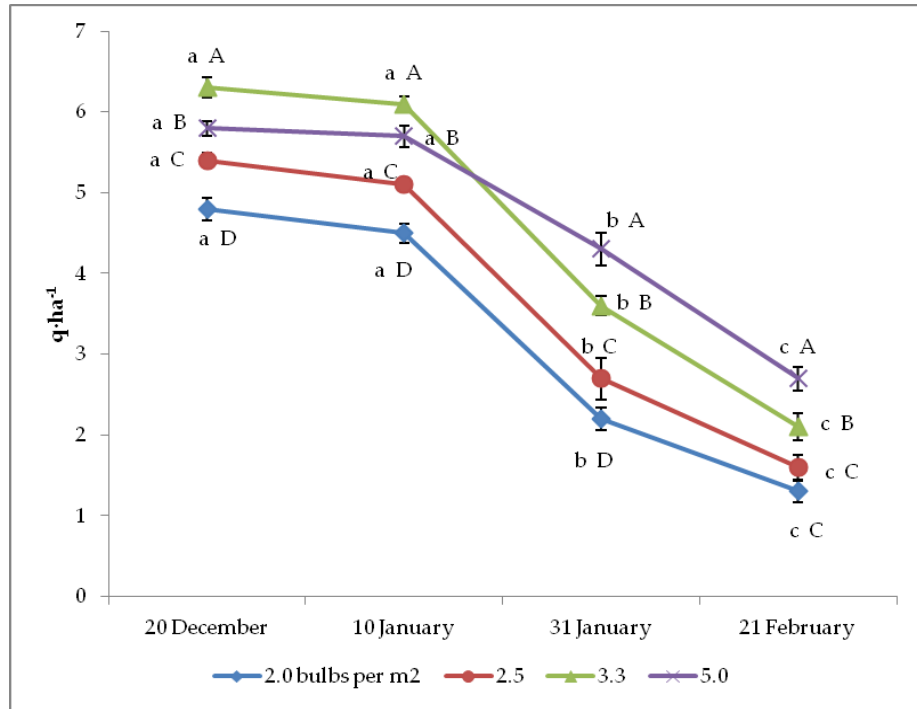
Figure 2. Interaction between bulb planting time and density on onion seed yield per ha ( n = 3). Different letters mean significant difference in the comparison between planting times (lowercase letters) or between bulb densities (capital letters), according to the Duncan test at p ≤ 0.05. Standard deviation bars are shown per each value.